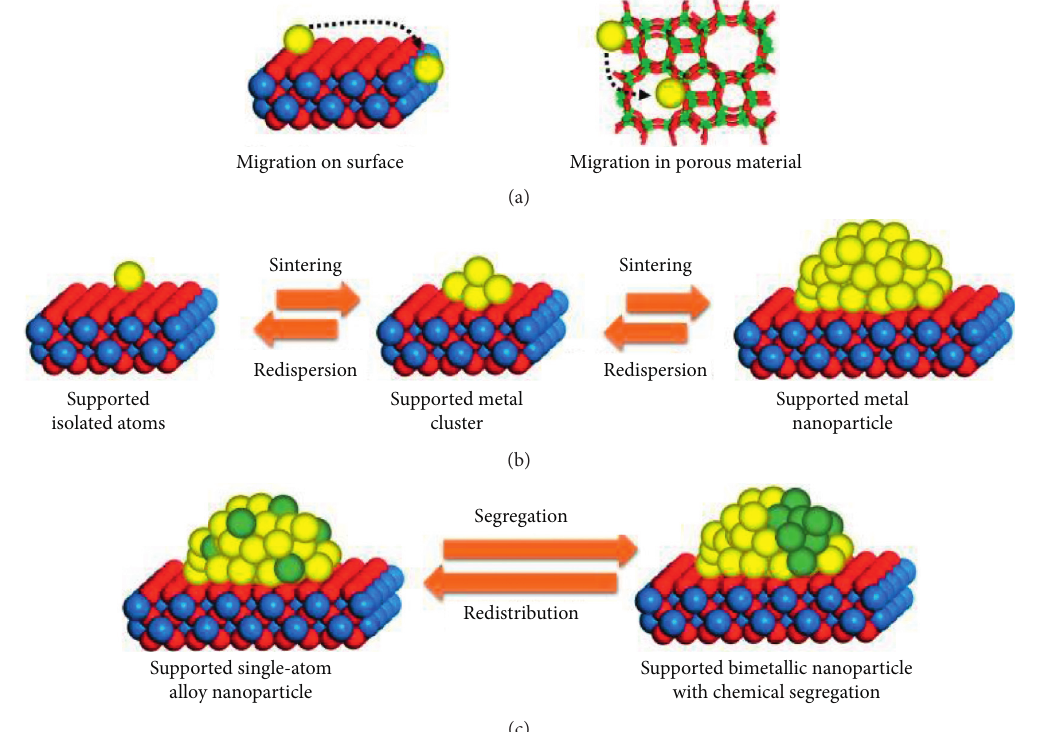
Figure 11: The structures of heterogeneous metal catalysts adopted from [55]. (a) Change of coordination environment. (b) Change of size. (c) Change of spatial distribution of the chemical compositions.